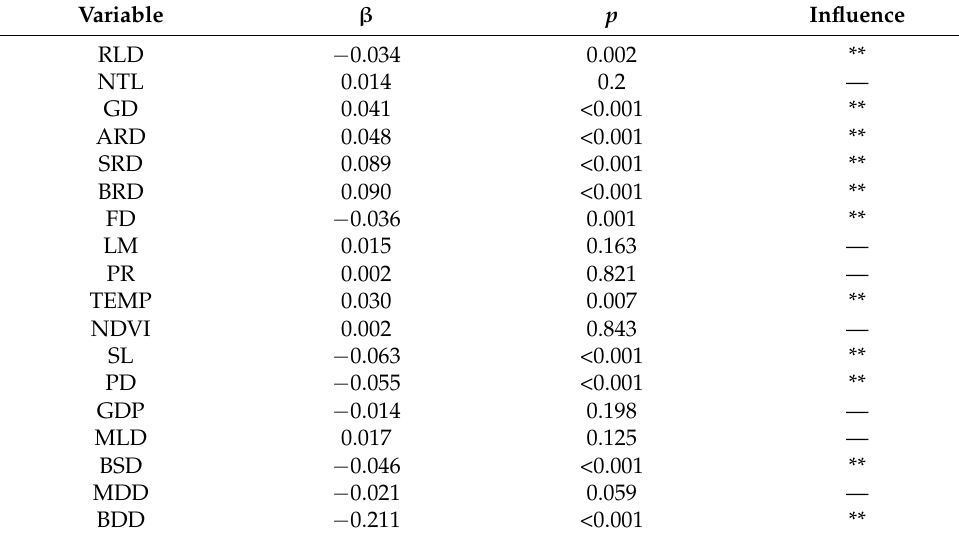
Table 3. Correlation analysis between footpath environment and residents’ JA.